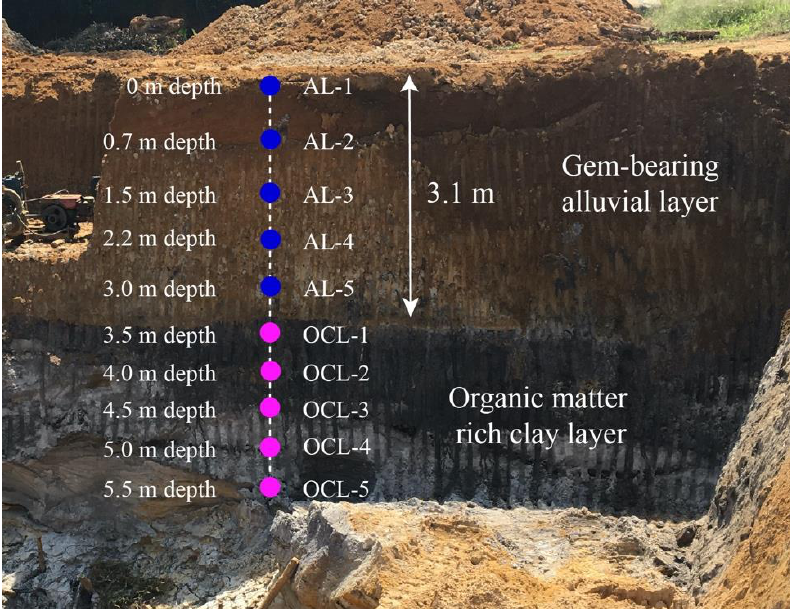
Figure 2. Sample locations with an illustration of the gem-bearing alluvial layer and organic-rich clay layers of the gem pit.